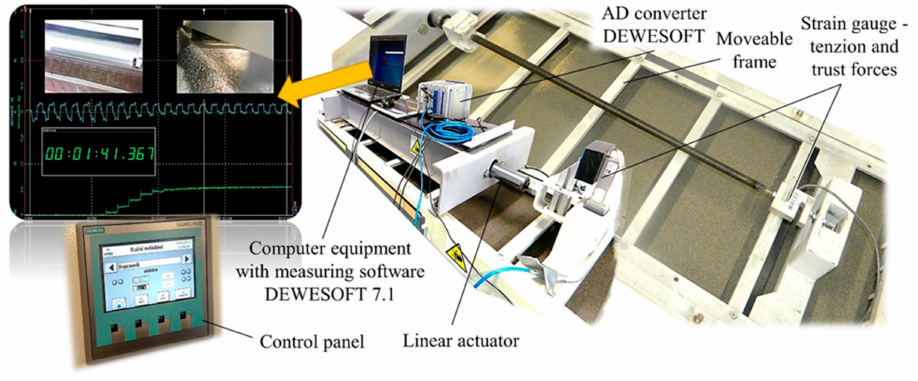
Figure 2. Testing equipment with control panel.